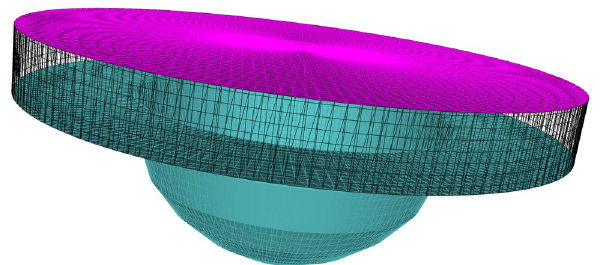
Fig. 1 Computational domain of variable compression ratio (VCR) engine